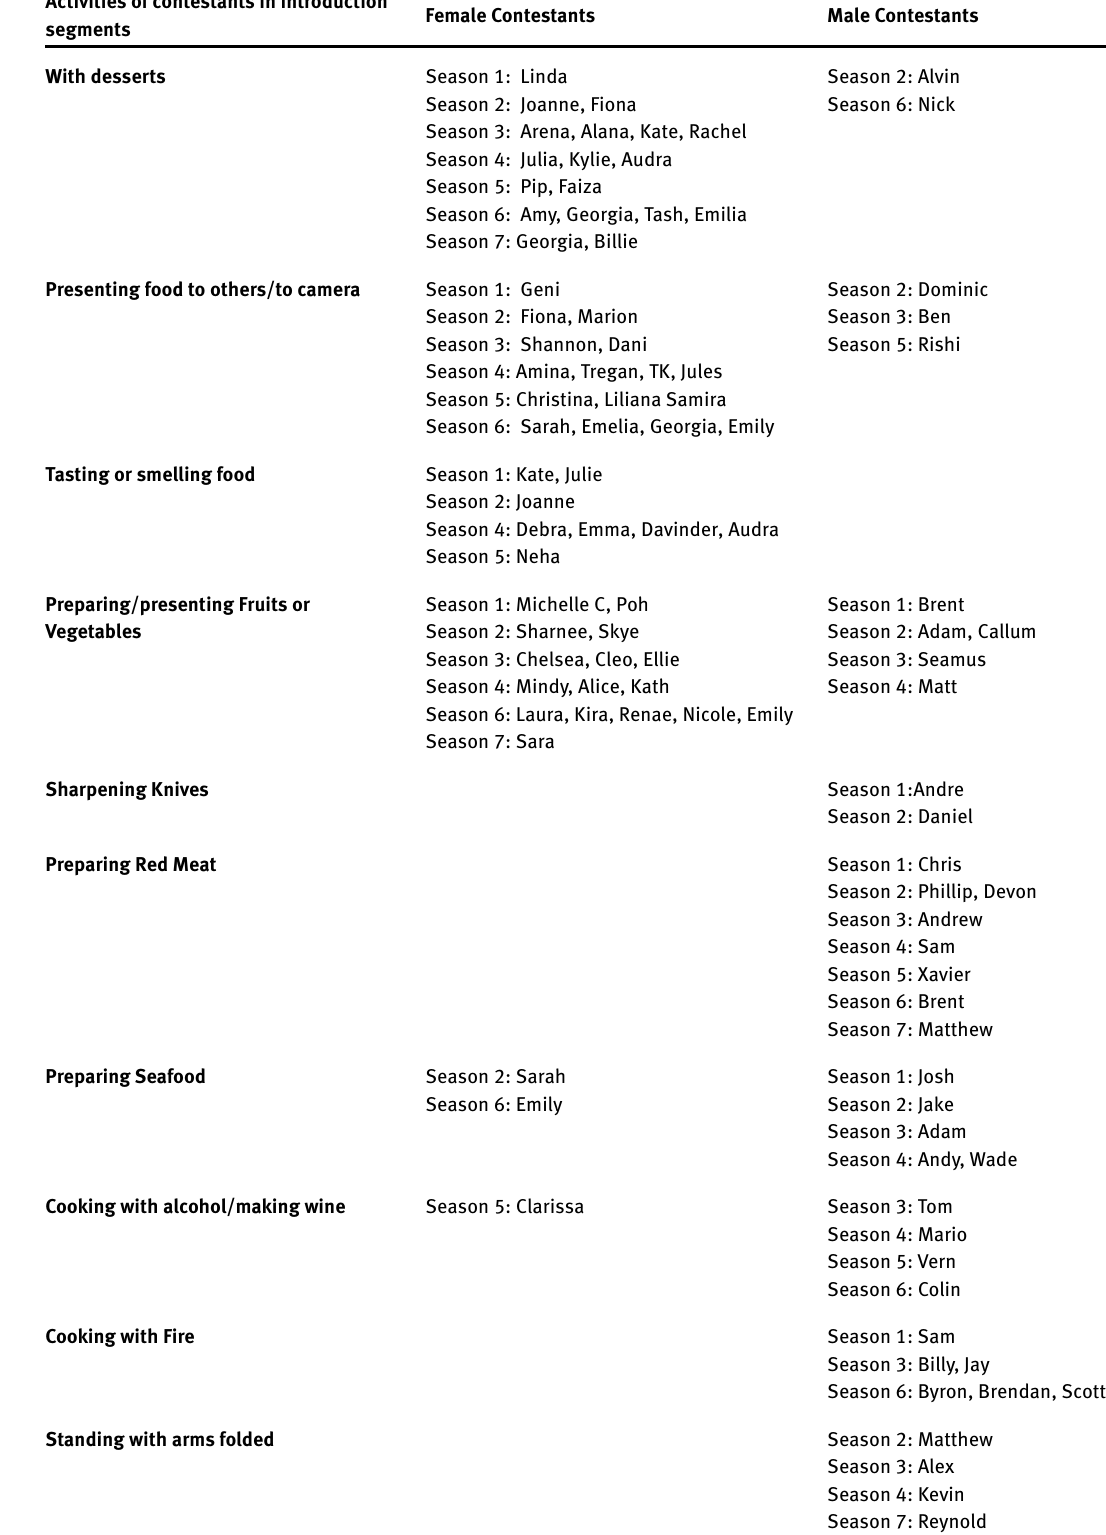
Table 4: Activities of contestants in the introduction segments of MCA Activities of contestants in